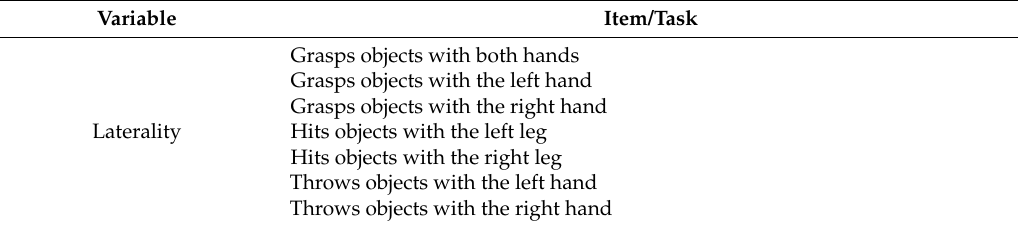
Table 2. Tasks evaluated (CPA